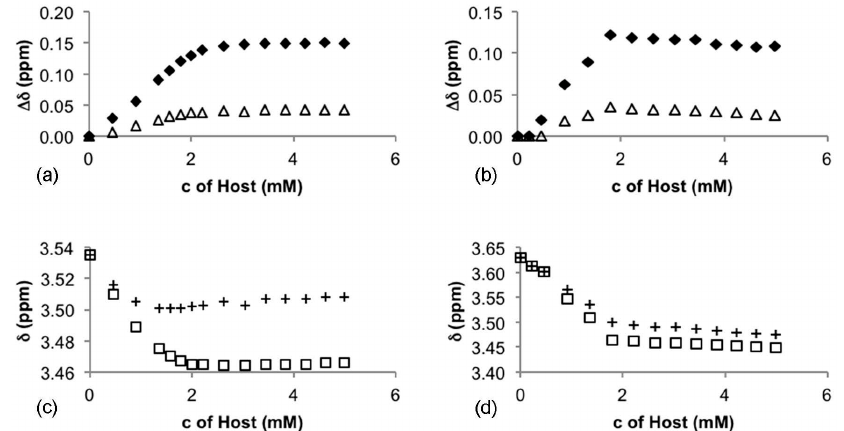
Figure 3. The magnitude of non-equivalence ( Δδ ): ( a ) of 3 with 5 (white triangle: 1 H-NMR and black diamond: 19 F-NMR) and ( b ) of 4 with 6 (white triangle: 1 H-NMR and black diamond: 19 F-NMR). The change of chemical shifts of S and R enantiomers: ( c ) of 3 as a function of the concentration of 5 (white square: R enantiomer and plus sign: S enantiomer) at 1 H-NMR; and ( d ) of 4 as a function of the concentration of 6 (white square: R enantiomer and plus sign: S enantiomer) at 1 H-NMR.